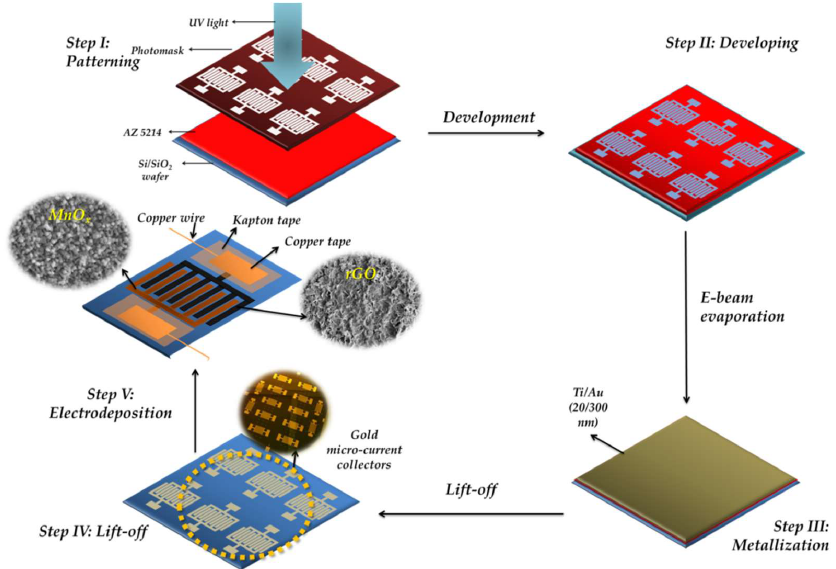
Figure 1. Schematic illustration of the asymmetric rGO//MnO x microsupercapacitor construction.